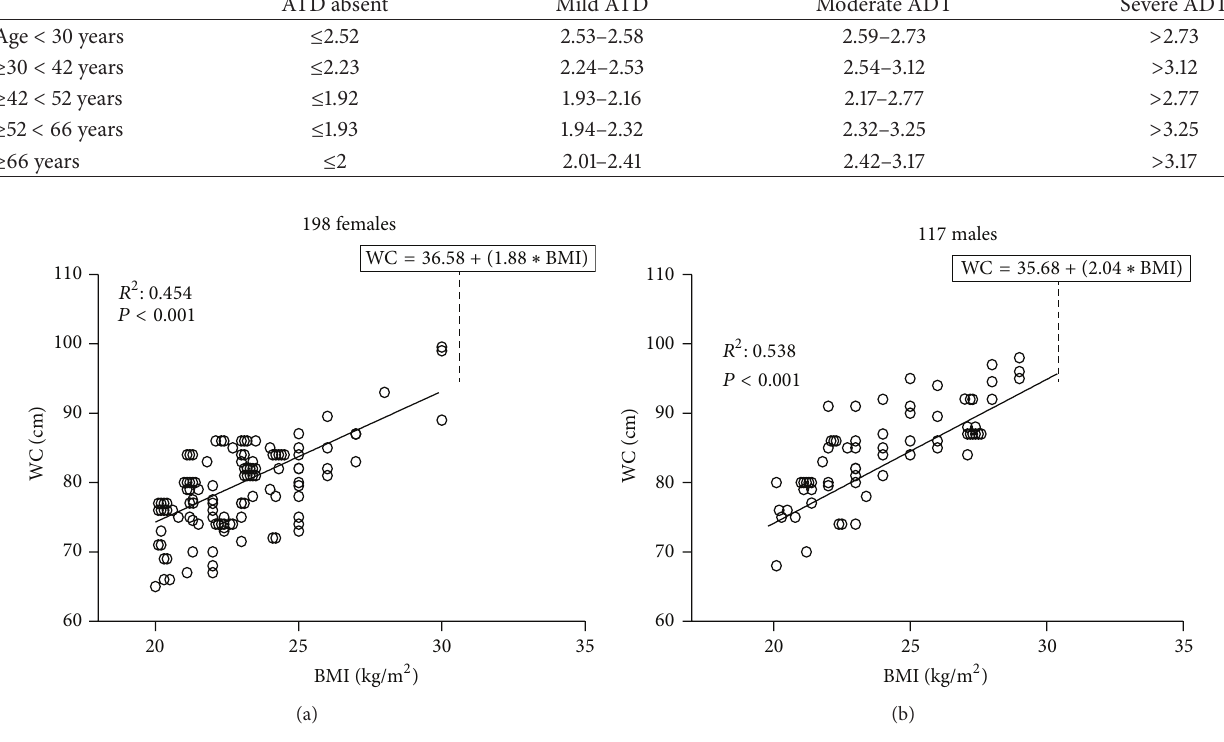
Figure 1: Linear relationship observed between BMI and WC in 315 primary care patients, with BMI between 20 and 30 Kg/m 2 and age 43.46 ± 14.30 years (range 19–83), selected because of absence of diabetes mellitus or FPG ≥ 5.6 mmol/L, high blood pressure, dyslipidemia, metabolic syndrome and cardiovascular disease (CVD). A model of adipose distribution (MOAD) was created based on this gender-specific linear equation. Taken from Amato et al.